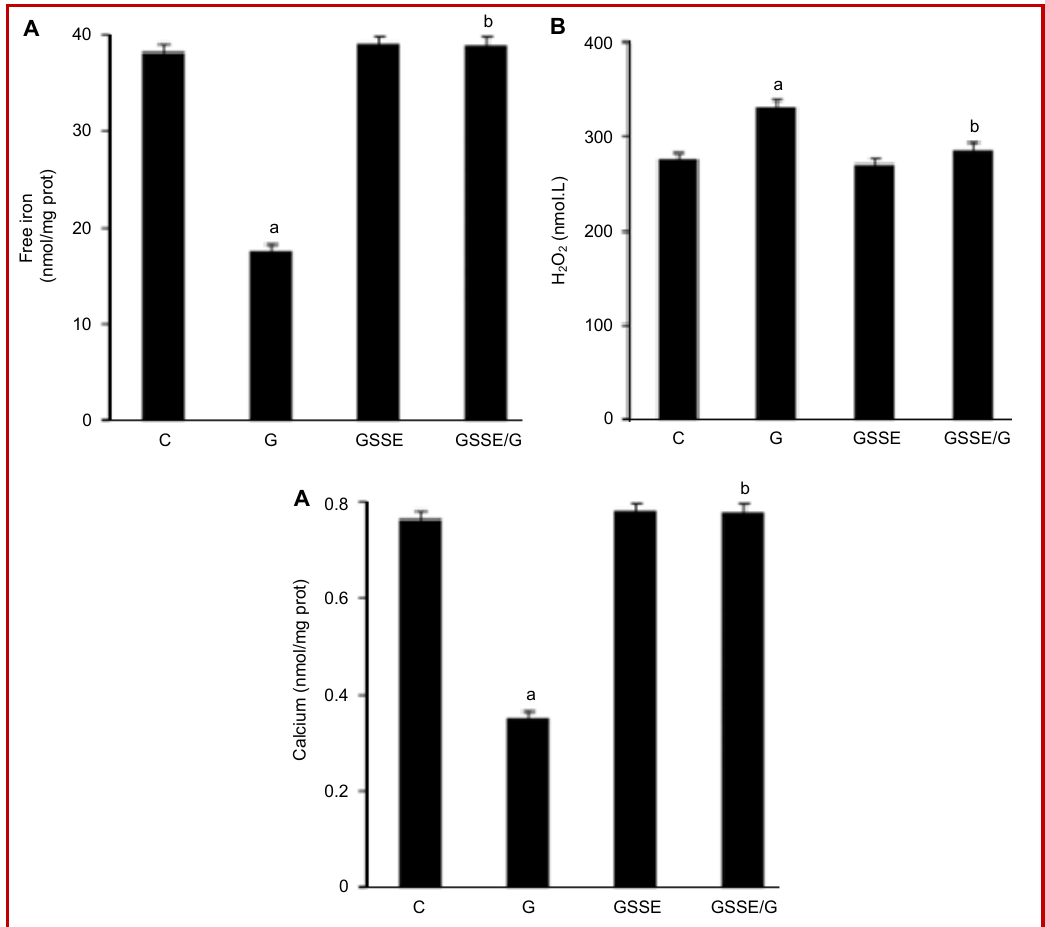
Figure 4: Effect of GSSE on garlic-induced intracellular mediators. Rats were daily administered with 10% ethanol (C), garlic (G), grape seed and skin extract (GSSE) or garlic plus GSSE (GSSE/G) for 1 month and renal free iron (A), H 2 O 2 (B) and calcium (C) levels were determined. Results are expressed as means ± SEM (n=10). a p<0.01 vs C. b p<0.01 vs